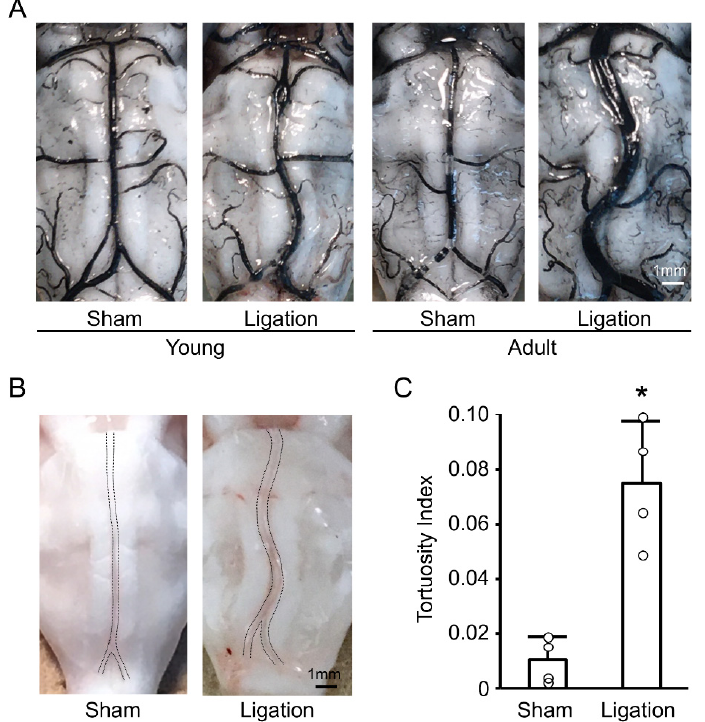
Figure 1. Bilateral common carotid artery (CCA) ligation induces basilar artery tortuosity in rats: ( A ) Representative India ink angiograms of young and adult rats at 4 weeks after bilateral CCA ligation; ( B ) Representative images of nonfixed basilar arteries of adult rat at 4 weeks after bilateral CCA ligation; ( C ) Tortuosity index of nonfixed basilar arteries of adult rats at 4 weeks after bilateral CCA ligation. n = 4 for each group. * p < 0.05.